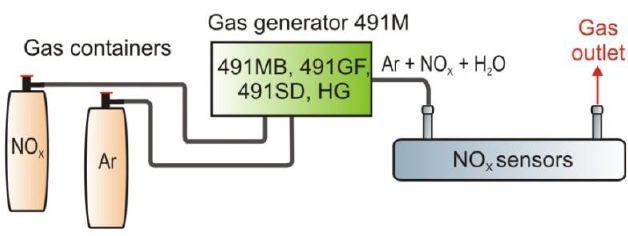
Figure 20. Block diagram of the setup designed for the sensor